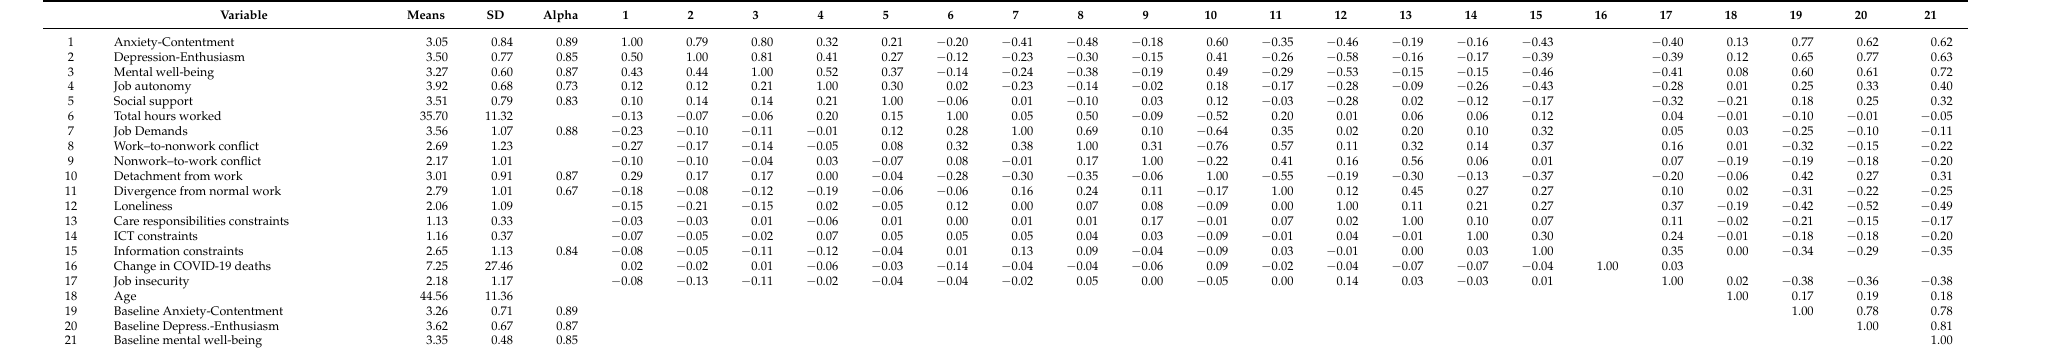
Table 3. Descriptive Statistics and Correlations for Phase